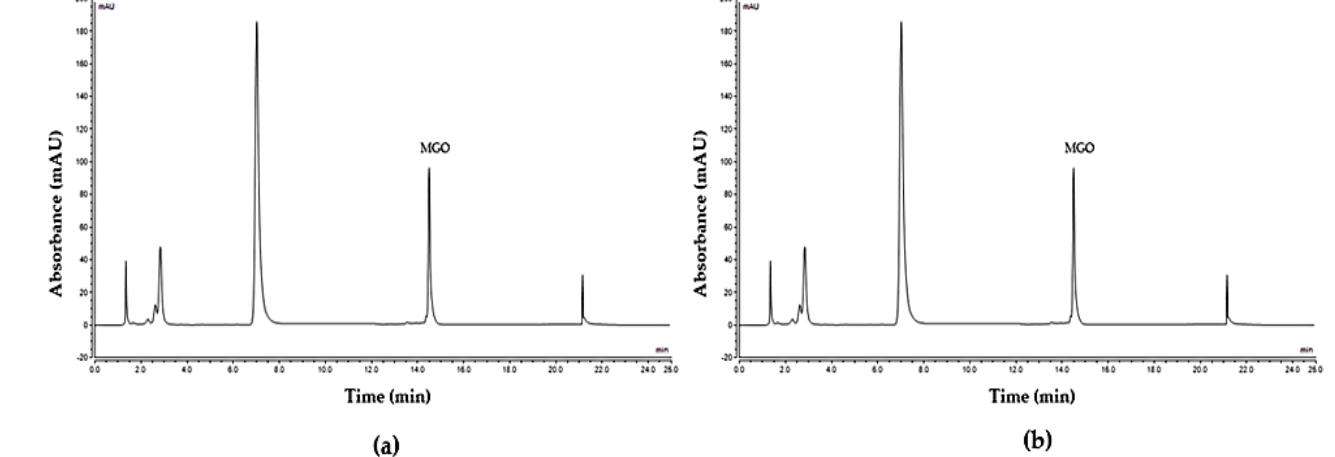
Figure 5. Peak profile of MGO solution (0.6 mg/mL) at RT 14.49 ( a ) Baseline ( b ) Released at 20 min. Buffer control gave additional peaks.